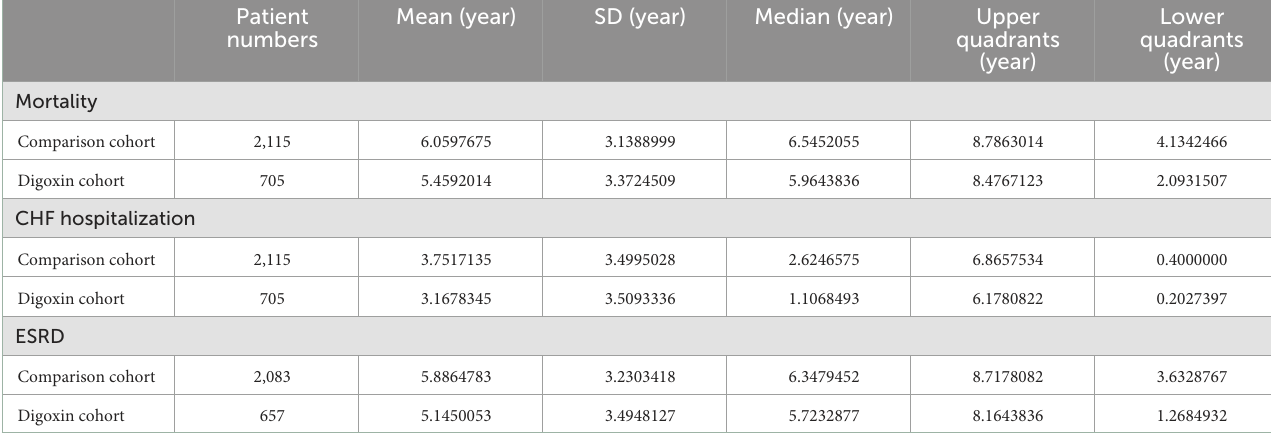
TABLE 3 Follow-up period of mortality, CHF hospitalization, CAD hospitalization, and ESRD between digoxin users and